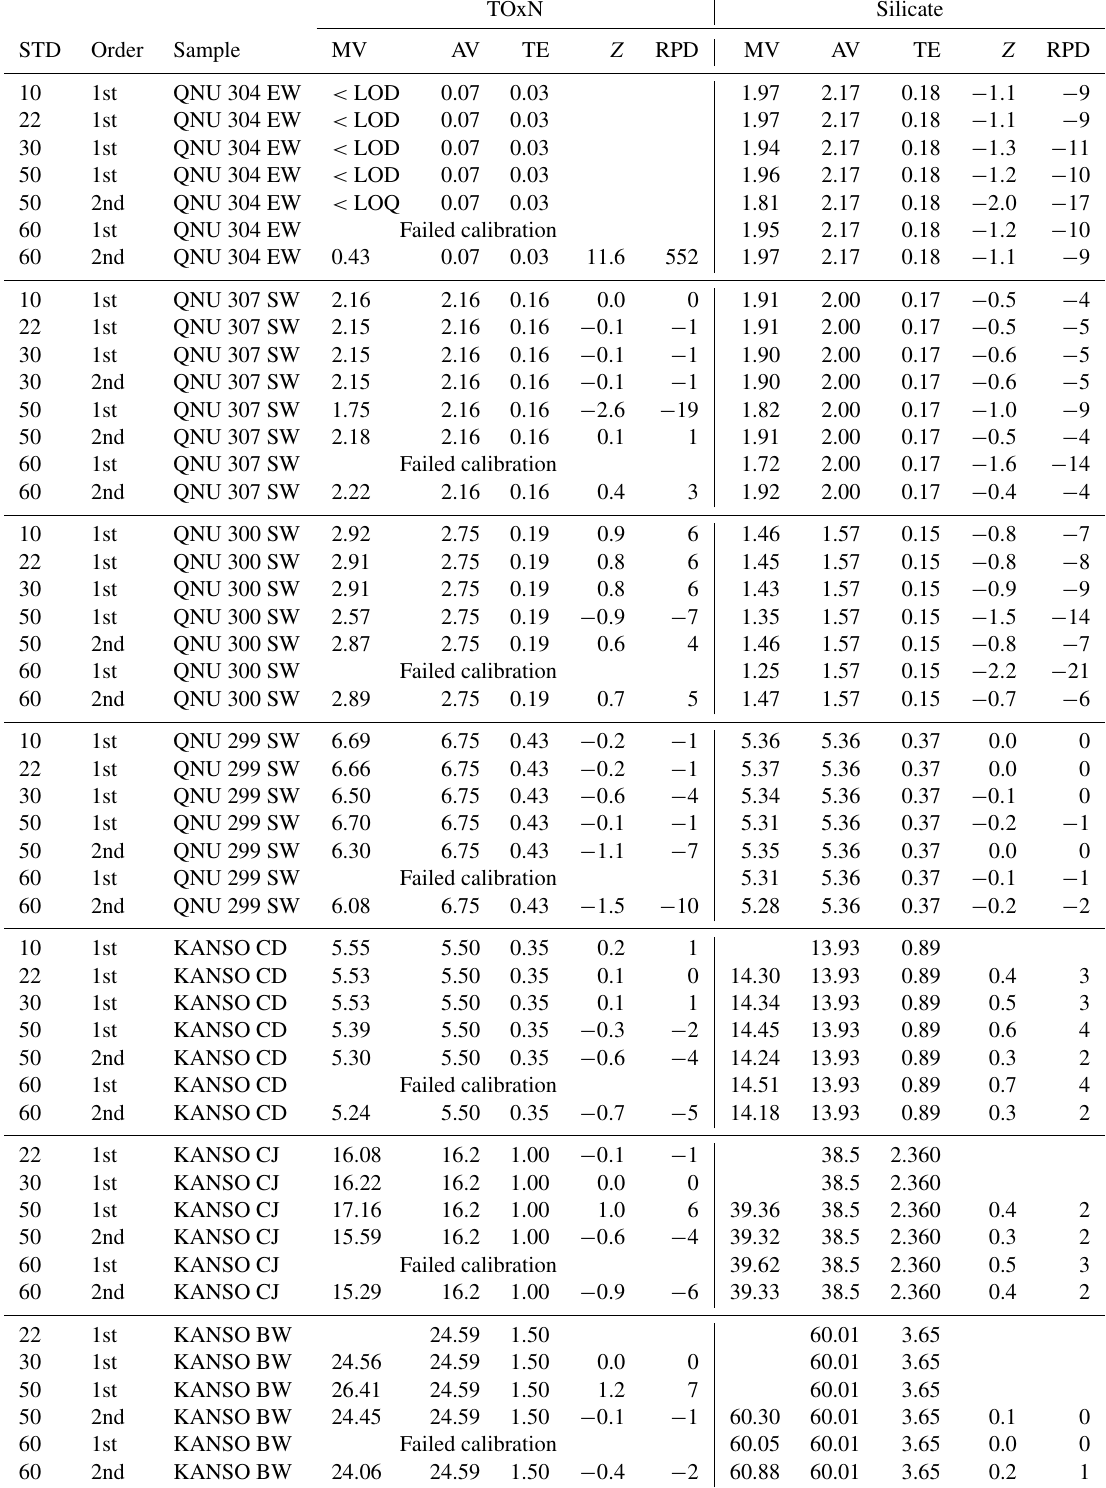
Table 7. Results from a laboratory experiment testing the effect of using different calibration ranges, where STD in the first column of the table indicates the top standard included in the calibration. The second column (order) indicates whether the first- or second-order calibration coefficient was used in the calibration. The samples are either QUASIMEME test materials (QNU) or KANSO CRMs; MV is the measured value; AV is the assigned (or certified value); TE is the total error used for calculating the z score; Z is the calculated z score as per Eq. (1) and RPD is the relative % difference (MV − AV / AV × 100%). LOD and LOQ are the limits of quantification and detection,